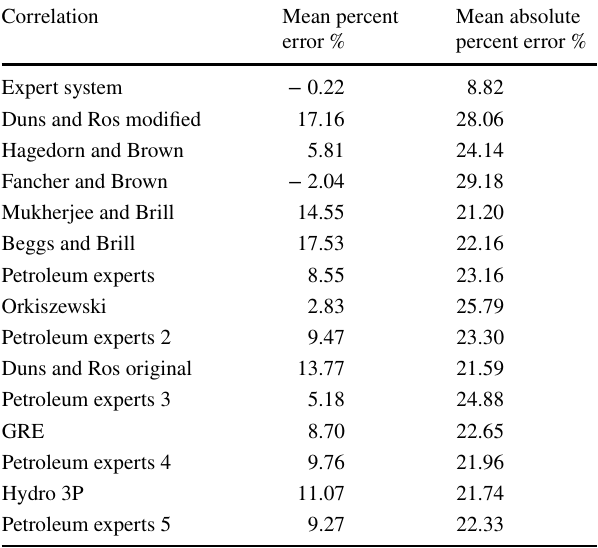
Table 7 Performance results of the expert system versus all correla- tions for validation